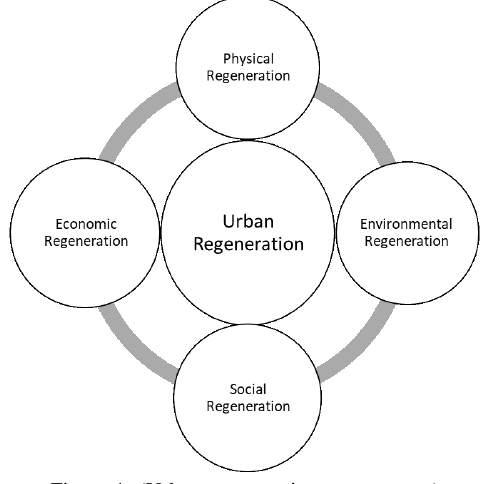
Figure 1. (Urban regeneration